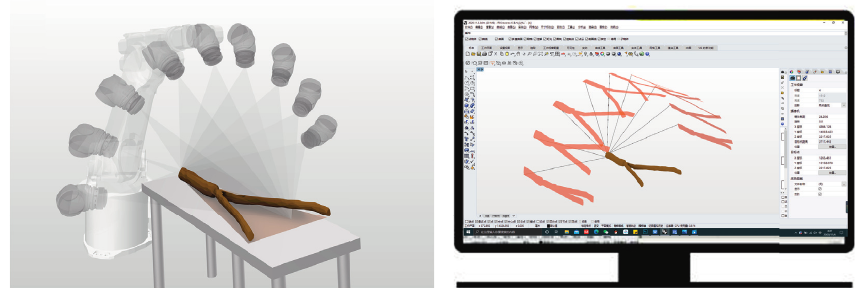
Figure 4: Perception-modeling system for small branches.